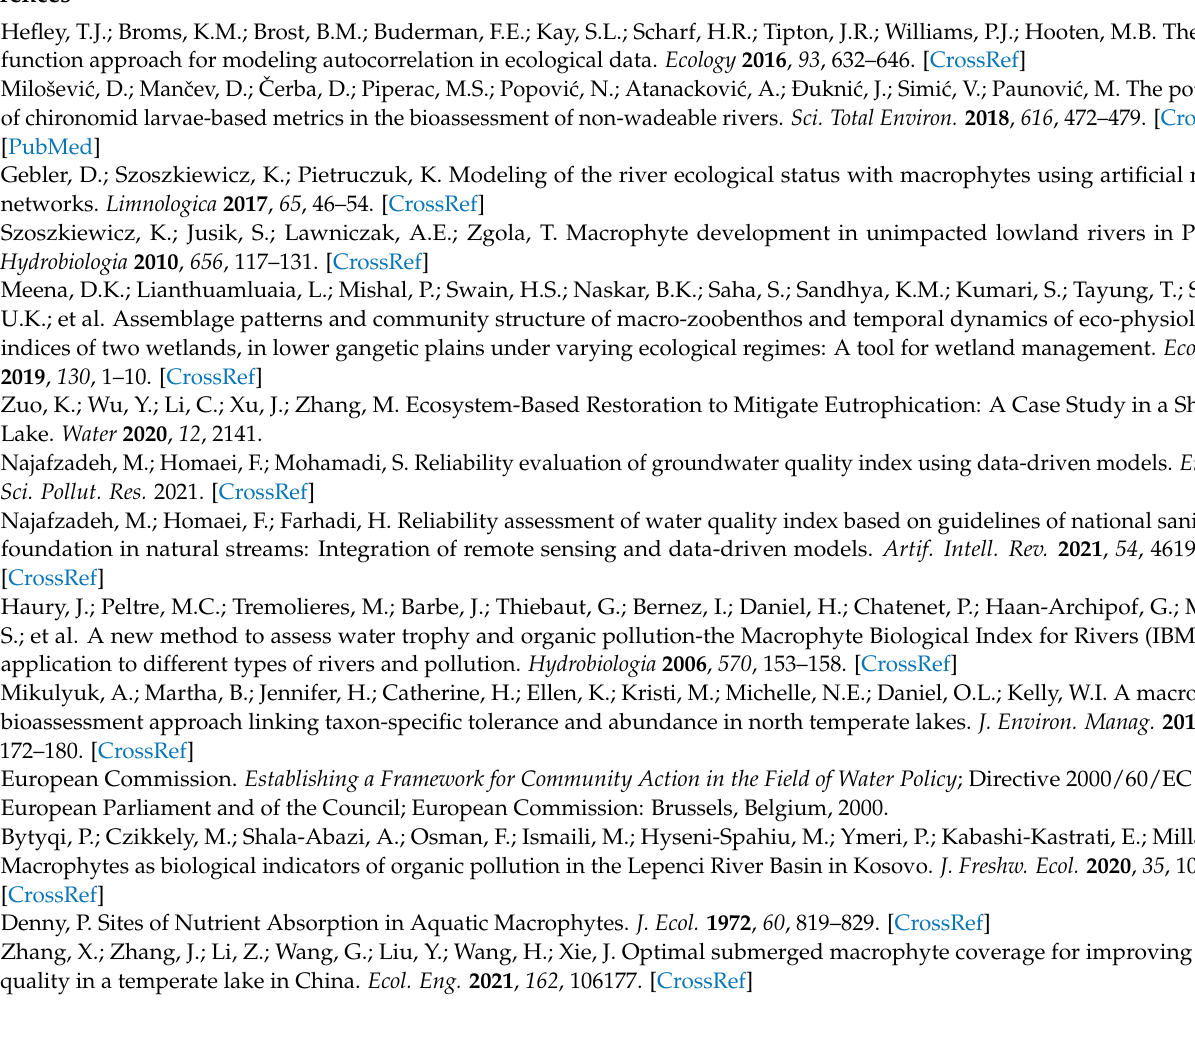
Supplementary Materials: The following are available online at https://www.mdpi.com/article/ 10.3390/w13192708/s1, Figure S1: Comparison of predicted and observed MIR, Figure S2: Com- parison of predicted and observed RMNI, Figure S3: Comparison of predicted and observed IBMR, Figure S4: Comparison of predicted and observed D, Figure S5: Comparison of predicted and ob- served N, Figure S6: Correlation between Independent Variables, Table S1: Equations for Macrophyte indices